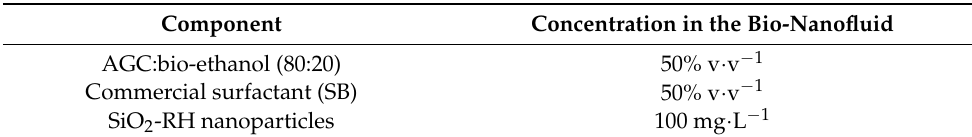
Table 3. Concentration of AGC:bio-ethanol (80:20), commercial surfactant (SB), and SiO 2 -RH nanopar- ticles in the tuned bio-nanofluid.